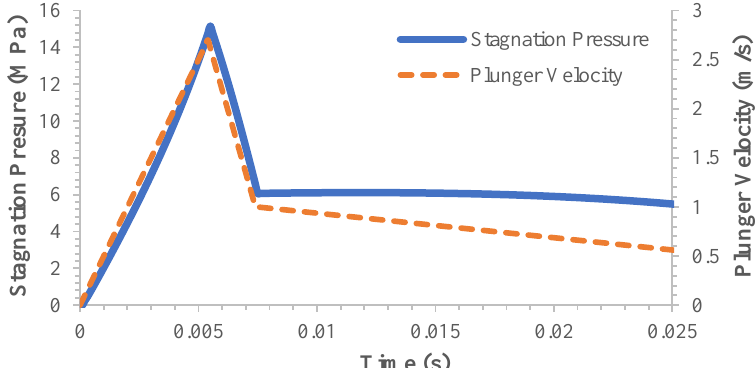
Figure 11. Pressure Profile representing typical behavior of commercially available injectors.